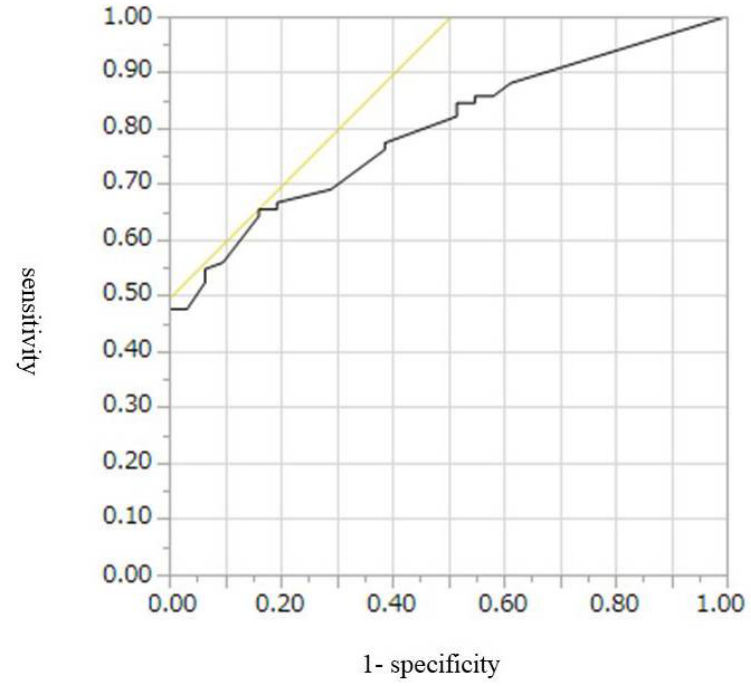
Figure 4. Receiver operating characteristics curve of the presence of mural lesions on CH-EUS for the diagnosis of malignant IPMN. CH-EUS, contrast-enhanced harmonic endoscopic ultrasonography; IPMN, intraductal papillary mucinous neoplasm.